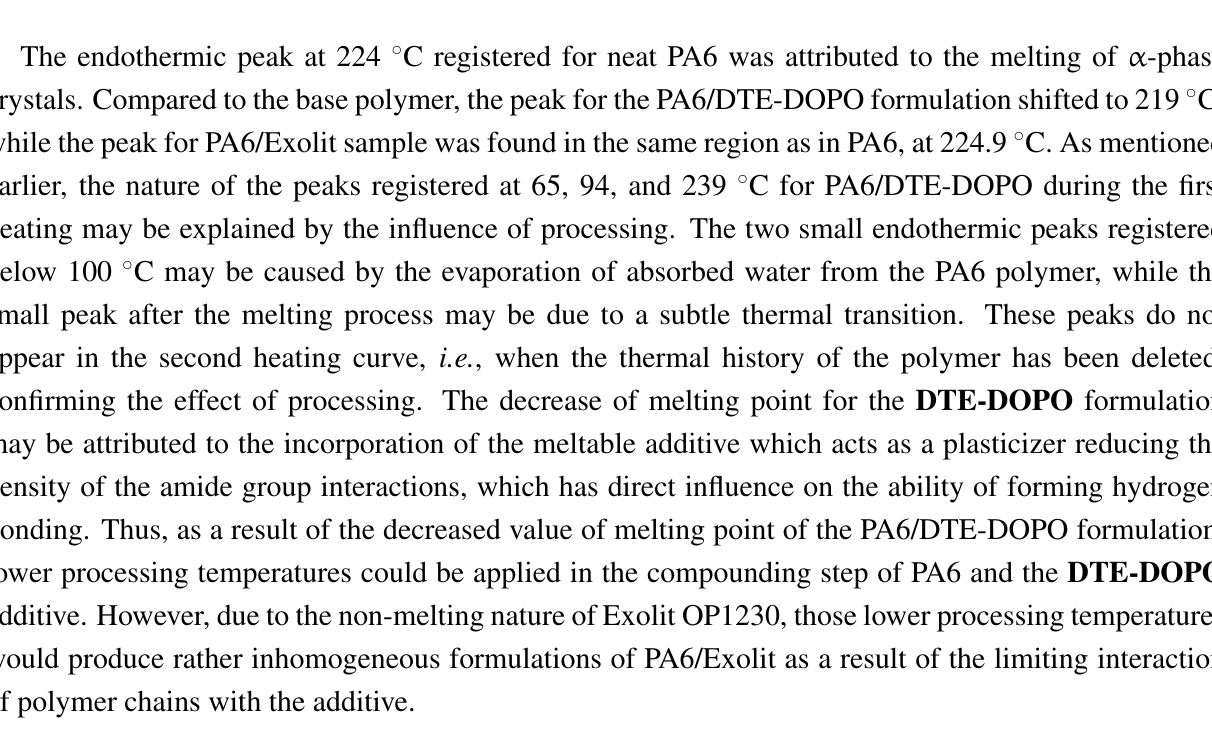
Figure 3. DSC measurements for PA6 formulations on first ( a ) and second ( b ) heating scan.